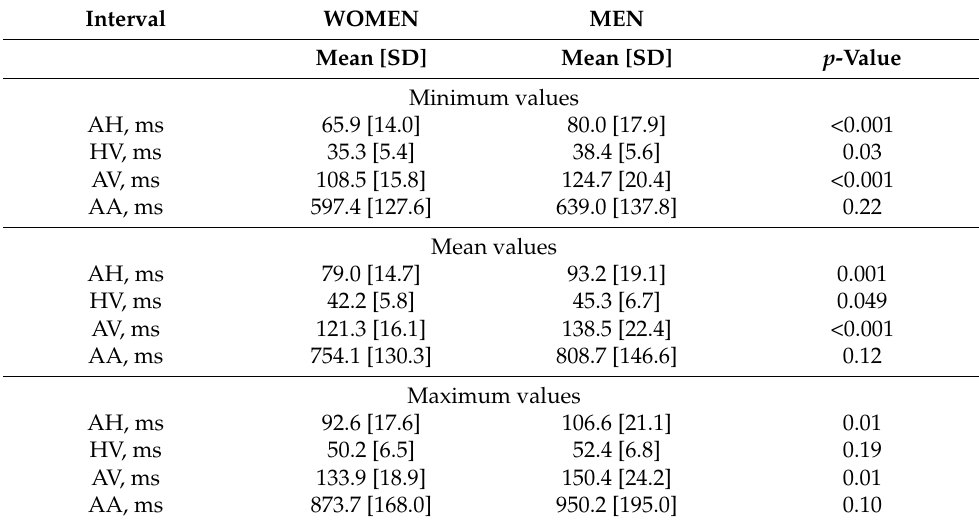
Table 3. Comparison of AH, HV, AV, and AA interval duration between men and women.